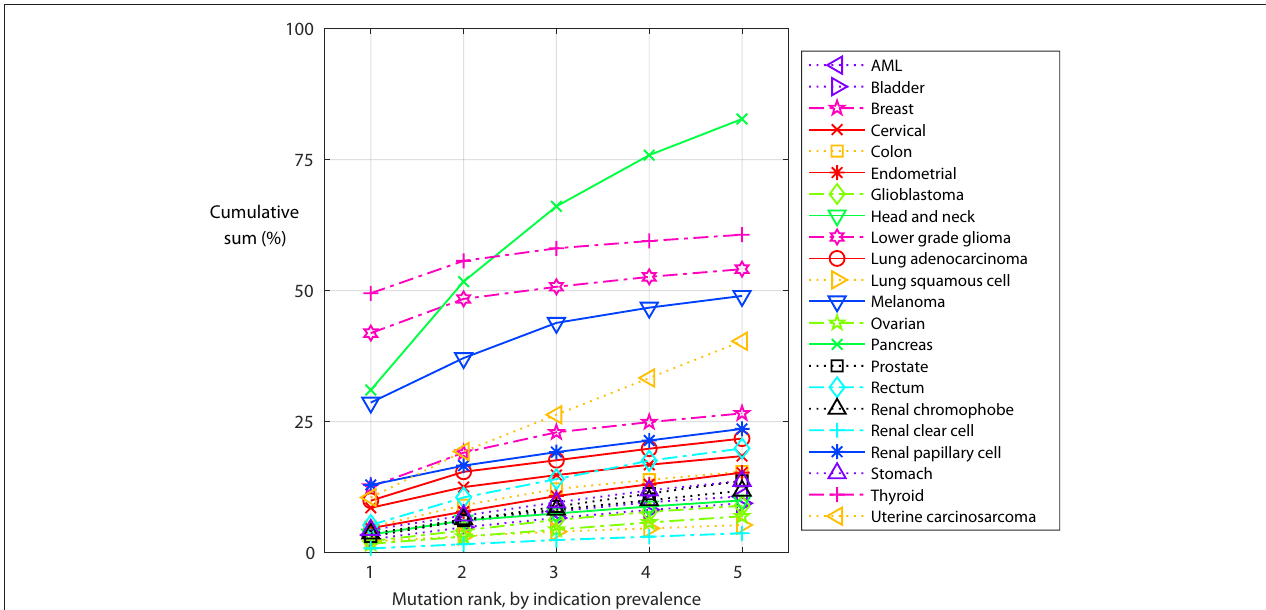
FIGURE 5 | Indication-specific cumulative sum frequency of the most frequent mutations. For each indication, the mutations are ordered by frequency and the cumulative sum calculated, assuming mutations do not co-occur.